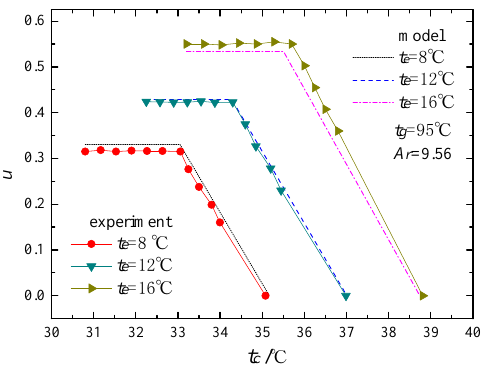
Figure 10. Comparisons of theoretical entrainment ratios with experimental values using R245fa as a working